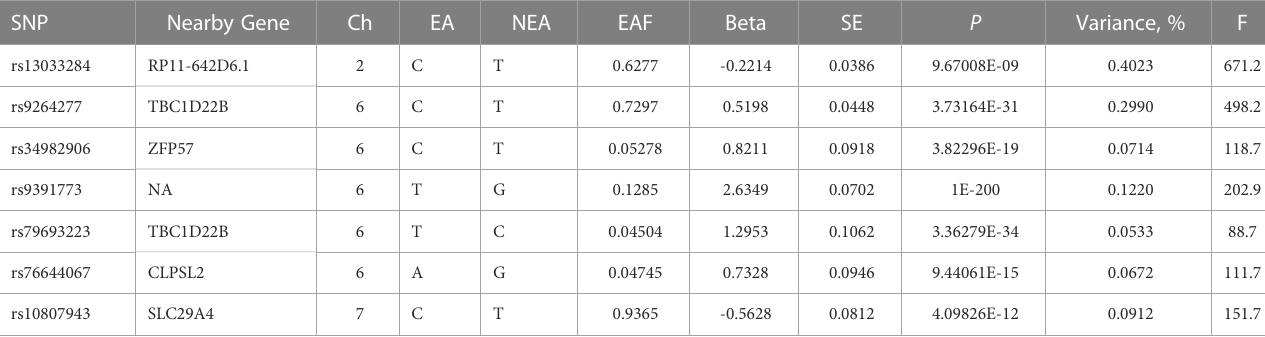
TABLE 2 Characteristics of the AS-Associated Genetic instrumental